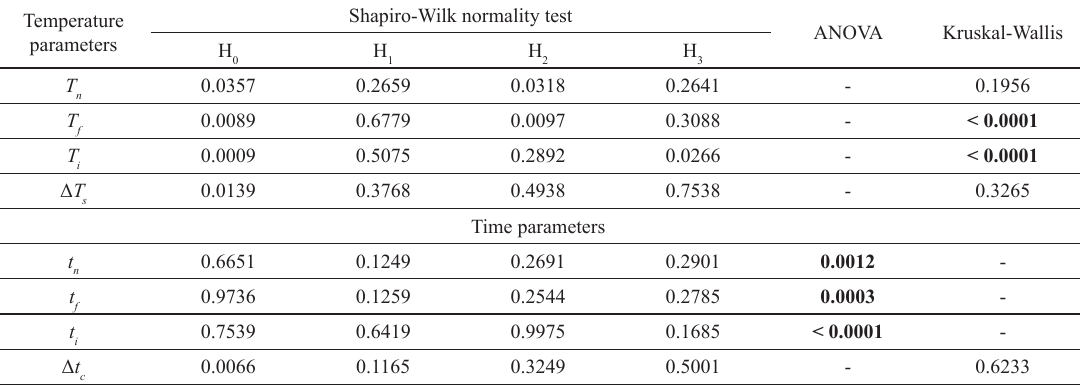
Table 2. p -values obtained after applying the Shapiro-Wilk test to check the normality of the data and the Kruskal-Wallis and ANOVA tests to study the significance of the magnetic field on the freezing of CoNHH. Figures in bold indicate the parameter that has a significant effect on the magnetic field.